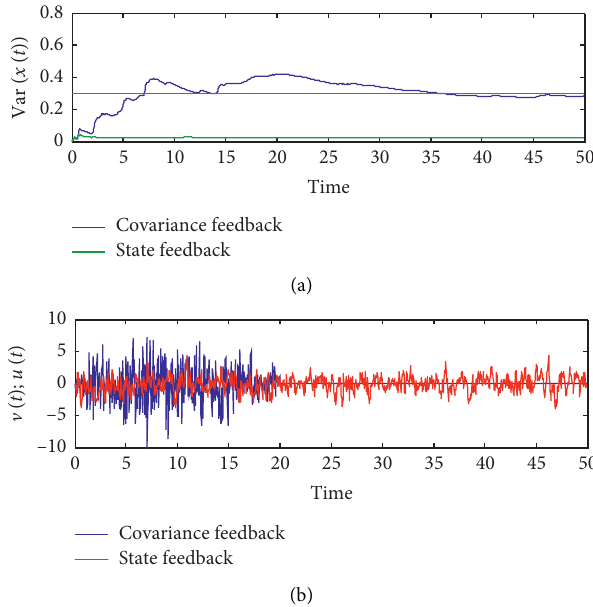
Figure 3: State variance and control signal of controlled system with proposed controller and state feedback approach [9]: (a) covariance tracking problem; (b) control